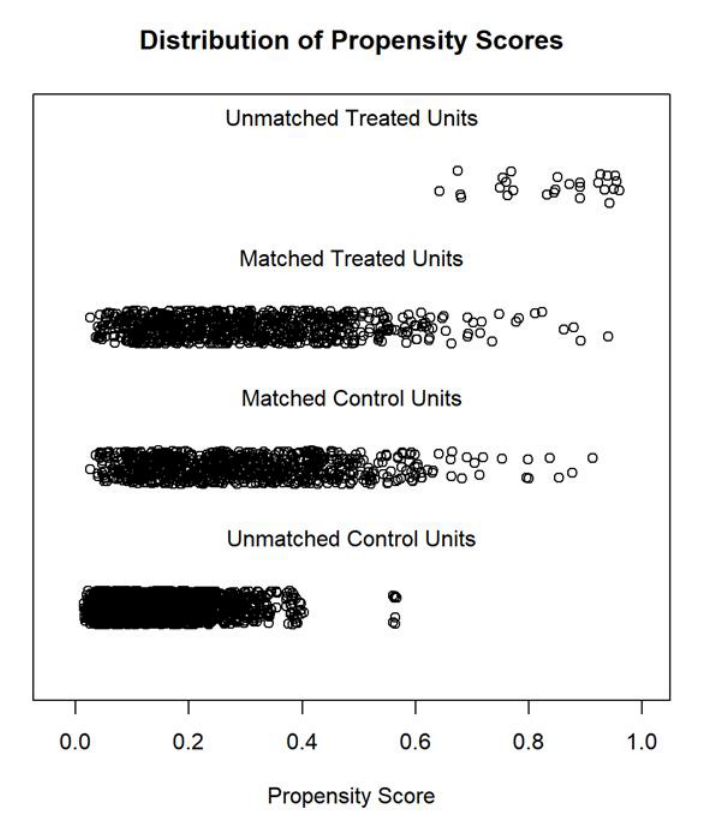
Figure 1. Propensity score distribution of the primary and the matched cohort. Table 2. Comparison of covariates in matched cohort.